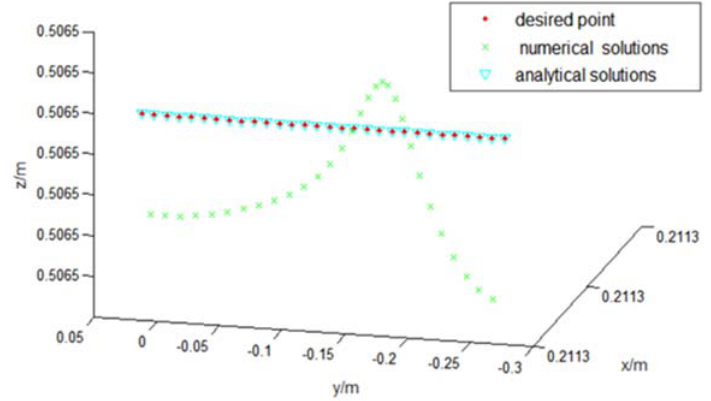
Figure 4. Comparisons of two inverse kinematics solutions.